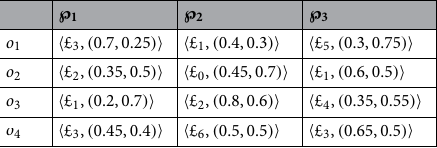
Table 3. q-rung orthopair linguistic decision matrix provided by d 3 .